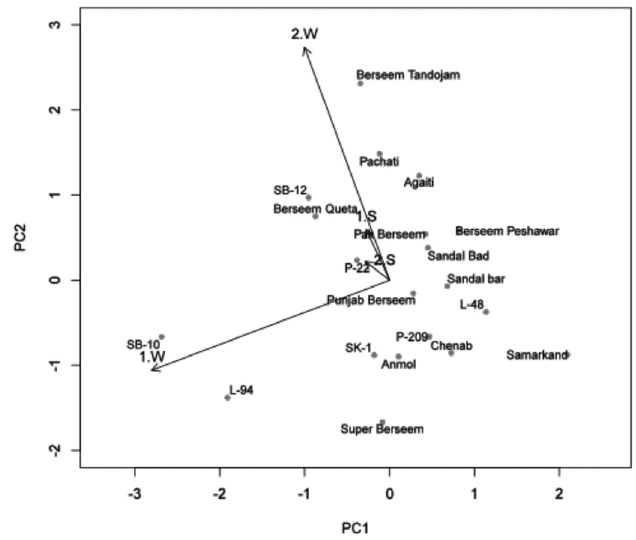
Fig. 1: GGE biplot of fresh biomass in the first (1) and second (2) cuts under water restriction (S) full irrigation (W) for twenty ecotypes of berseem clover ( Trifolium alexandrinum